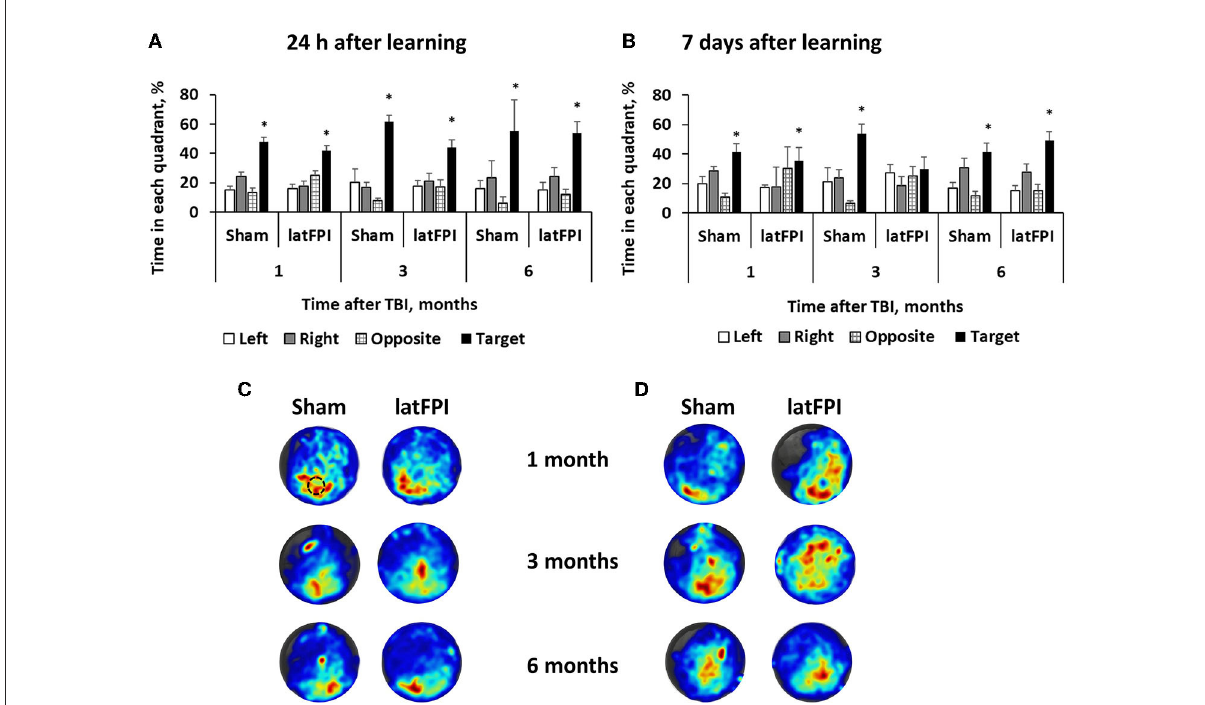
FIGURE5 Assessment of spatial memory by the Morris water maze 1, 3 and 6 months after latFPI. Percentage of time spent in each quadrant 24h (A) and 7 days (B) after the last training day. Heatmaps representing weighted occupancy across the entire 90s probe trial 24h (C) and 7 days (D) after the last training day 1, 3, and 6 months post-injury. Hot colors indicate longer dwell times. The platform area is denoted with a black circle. Data are expressed as mean ± SEM for the entire 90 sec, * p < 0.05 target quadrant vs. at least 2 other quadrants (one-way ANOVA followed by Dunnett’s multiple comparison